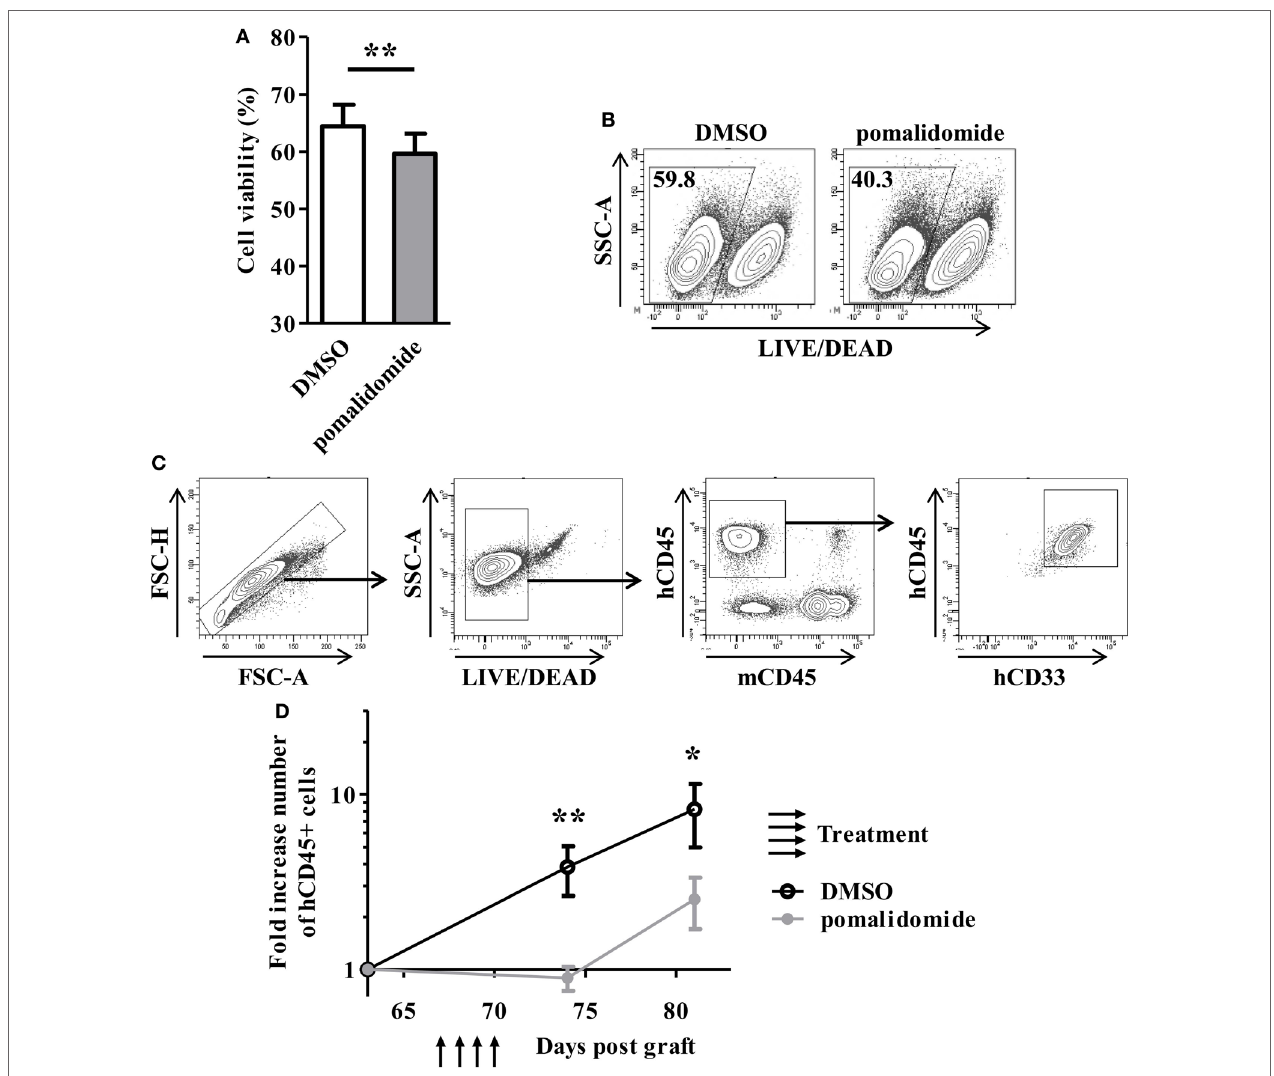
FigUre 1 | In vitro and in vivo exposure of acute myeloid leukemia (AML) blasts to pomalidomide induce tumor cell death and control leukemia growth. (a,B) Viable and death primary AML blasts were monitoring by flow cytometry using LIVE/DEAD discriminator staining. (a) Percentage of live cells after 48 h of culture with pomalidomide (10 µM) or DMSO control treatment ( n = 23) were expressed as mean ± SEM and statistical significance was established using paired Student’s t -test. (B) Representative dot plot from one experiment (patient upn20). (c,D) NSG mice ( n = 14) were irradiated on day 0 and i.v. inoculated with 1.10 6 CD3-depleted primary AML cells (from patient upn20) on day 1. When AML blasts were detected by cytometry in blood (day 64 post graft), mice were randomly assigned to be i.v. injected with pomalidomide (5 mg/kg) ( n = 7) or with DMSO ( n = 7) on days 67, 68, 69, and 70. Both group have comparable leukemia burden at day 64 before treatment (mean ± SEM, 6.8 ± 3.6 cells per μ L for DMSO group versus 7.4 ± 1.8 for pomalidomide group, p = 0.62) (c) Gating strategy for flow cytometry analysis. In murine blood samples, cells were first gated for singlets (FSC-H vs. FSC-A) and live cells (SSC-A vs. LIVE/DEAD aqua). The blasts were further gated based on the expression of hCD45 and hCD33, and absence of mCD45 expression. (D) Fold increase numbers of blasts quantified by FACS analysis in blood. For each mouse, the number of hCD45 + cells per microliter of blood at days 64, 74, and 81, was normalized to the number of hCD45 + cells before treatment (day